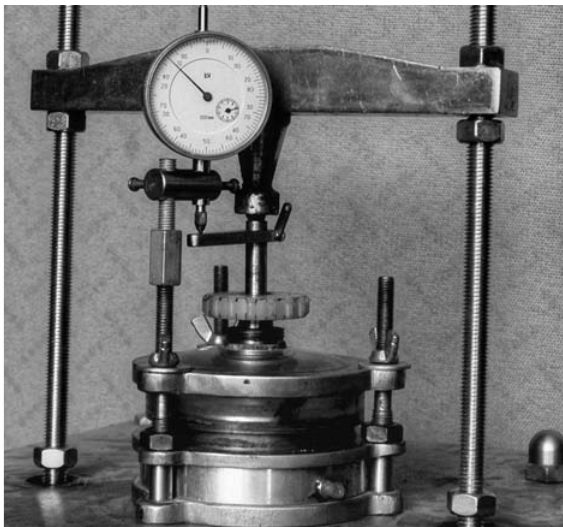
Fig. 5. Oedometer device (principal